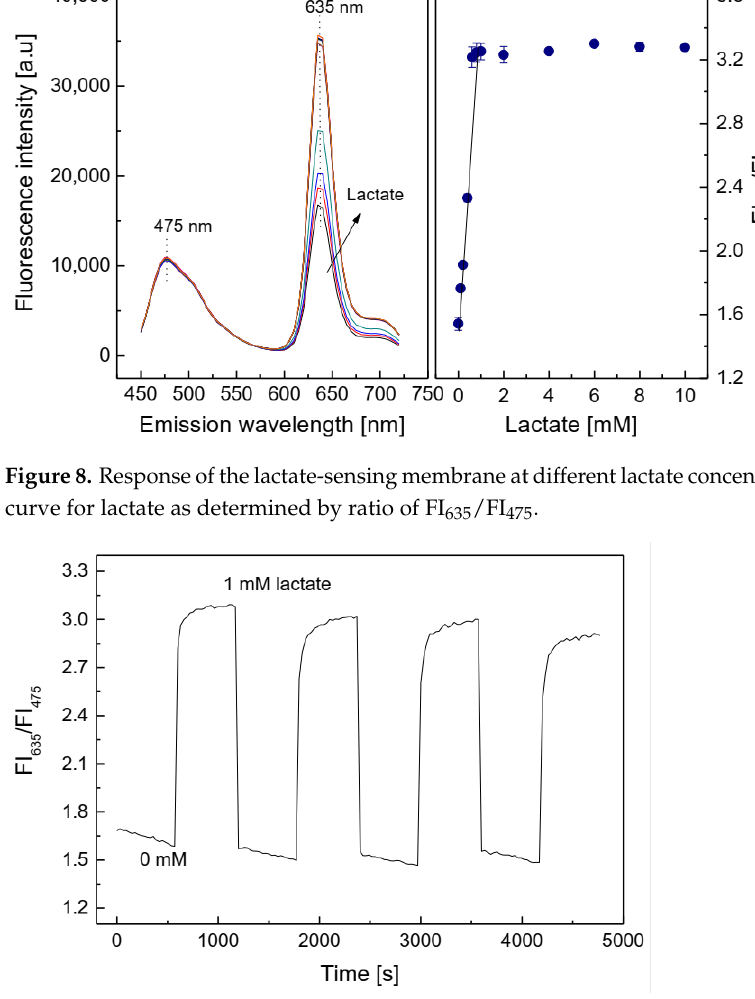
Figure 9. Reversibility of the lactate-sensing membrane repeatedly exposed at 0 and 1 mM